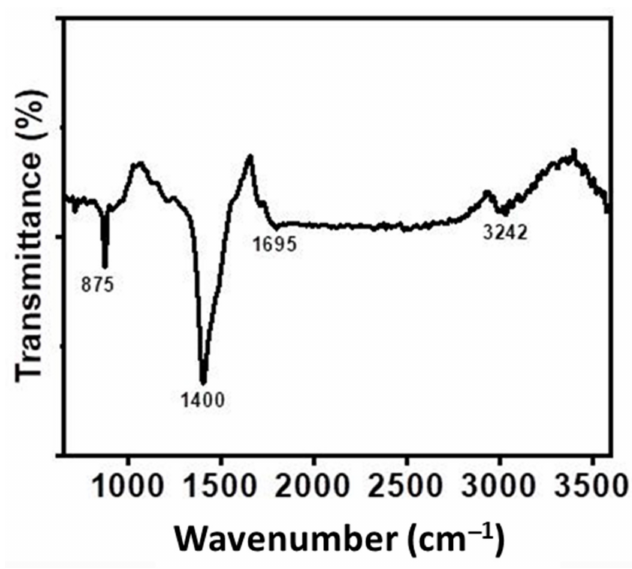
Figure 4. Identification of surface functional groups by FTIR spectra of the walnut shell